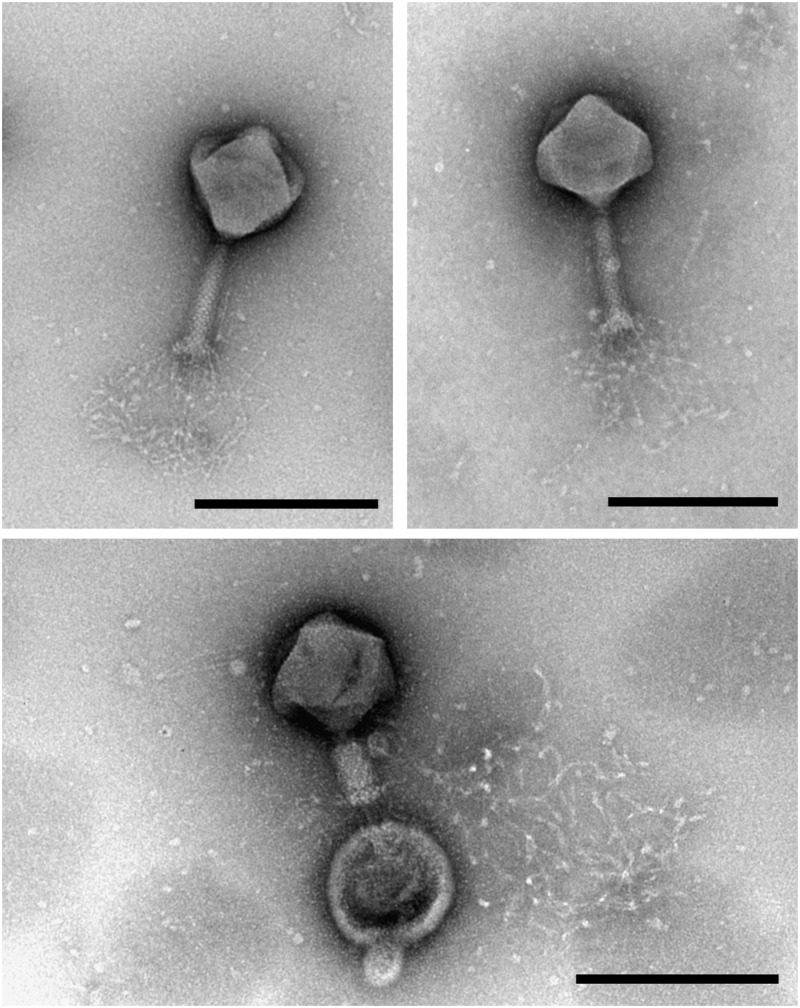
Transmission electron microscopy analysis of the purified phage MIJ3 revealed that MIJ3 belongs to the Myoviridae family and has an overall length of 258 nm. Phage MIJ3 possesses long tail fibers attached to the baseplate. Contracted tail can be observed upon interaction of MIJ3 with an outer membrane vesicle of P. aeruginosa (scale bar = 200 nm).